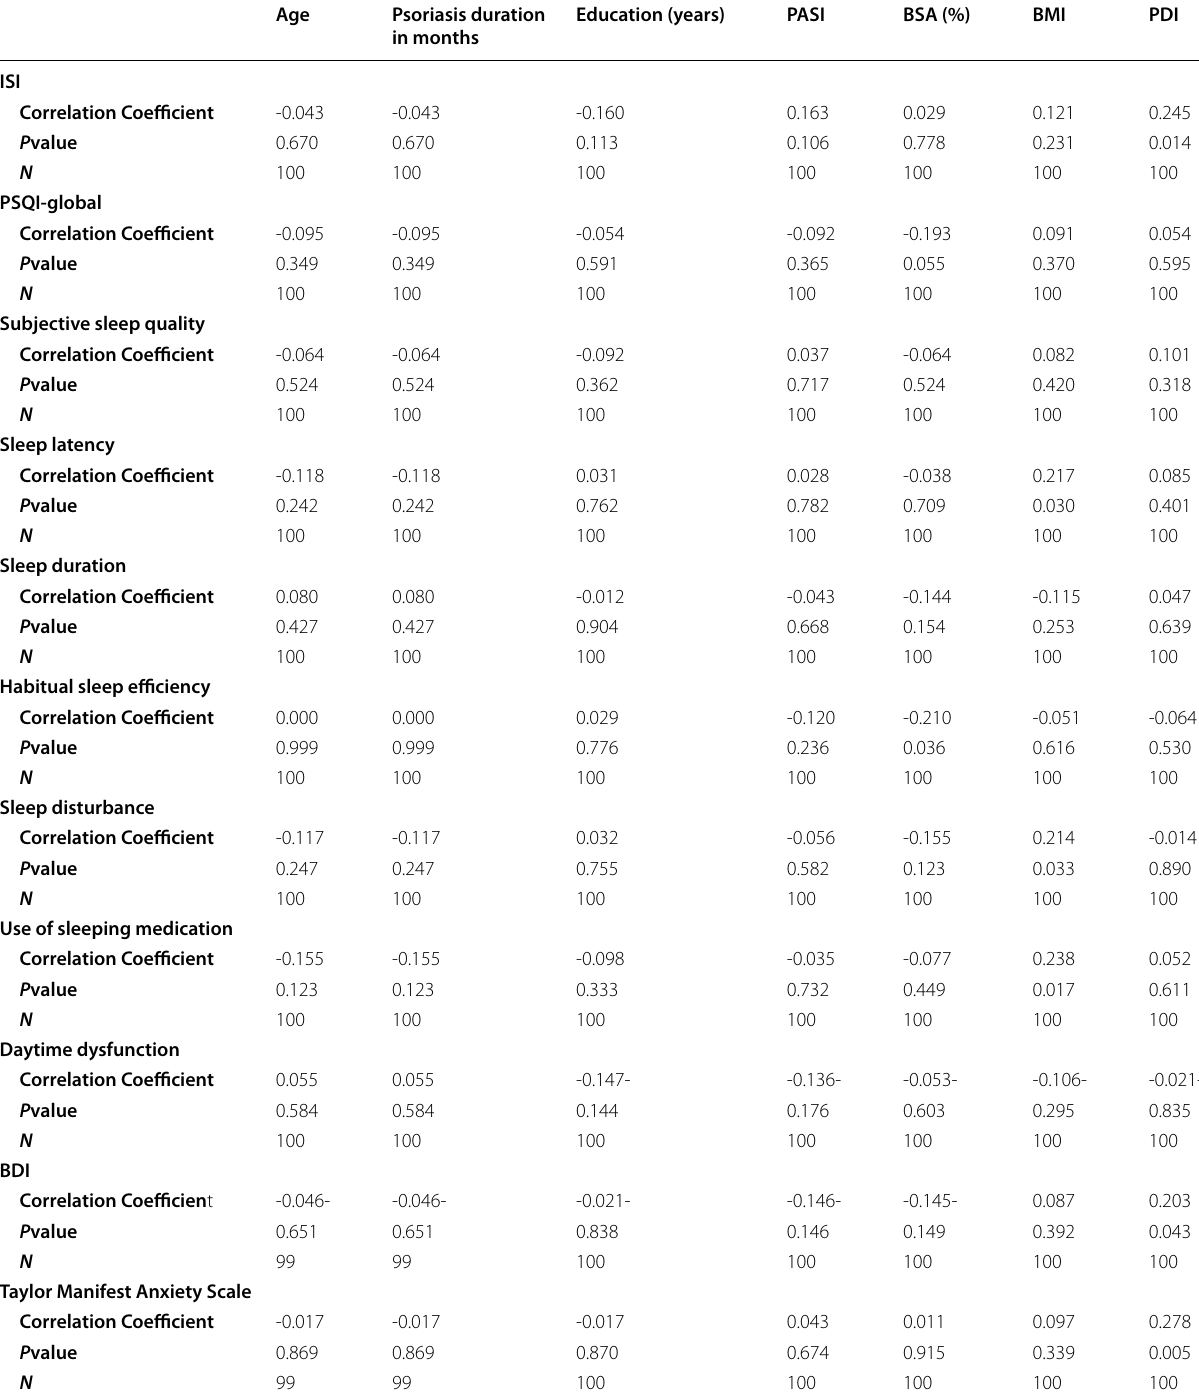
Table 4 Correlating patient’s clinical data with ISI, global PSQI and its subscales, BDI, and Taylor Manifest Anxiety